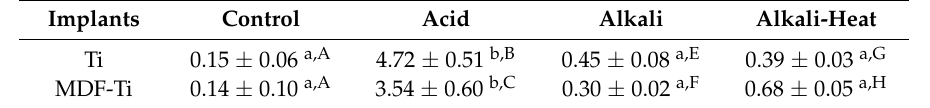
Table 3. Developed interfacial area ratio (surface deployment area rate) (Sdr) of surface-treated implants (%).